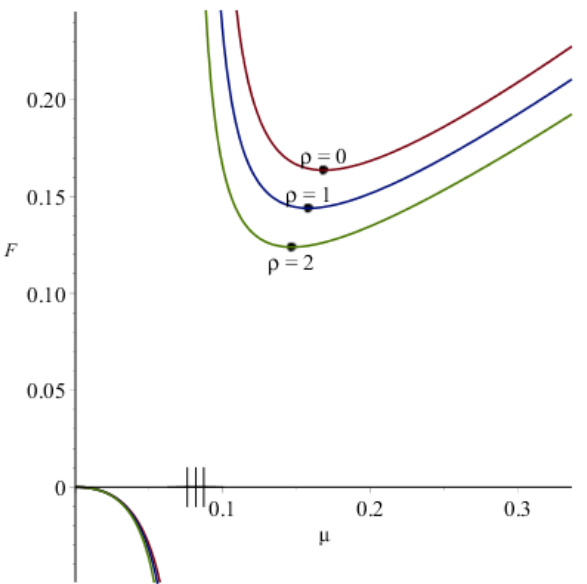
Figure A3. Function F ( µ ) from Equations (A4) and (6) at various ρ values. N = 10, other parameters are the same as in Figure A2. Notches on the µ -axis denote discontinuity points µ = µ 0 , closed circles denote minimum of the positive